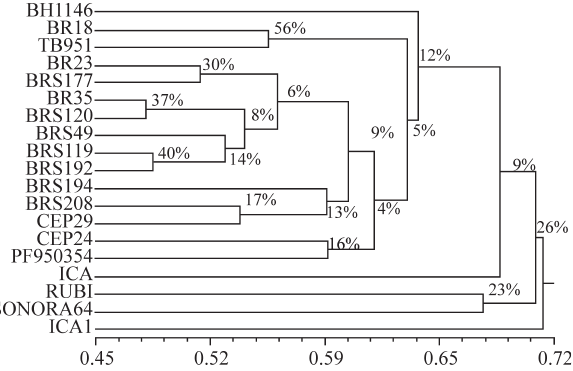
Figure 2 - Amplified fragment length polymorphism (AFLP) marker unweighted pair group method with arithmetic means (UPGMA) dendro- gram resulting from the analysis of 19 wheat genotypes using the comple- ment of the similarity index of Dice (1945) based on AFLP markers as a measure of genetic distance. The values found in the groups indicate the percentage number of times that the genotypes grouped together out of 1000 bootstrap cycles using the Winboot program. The value of the cophenetic correlation coefficient (r) was